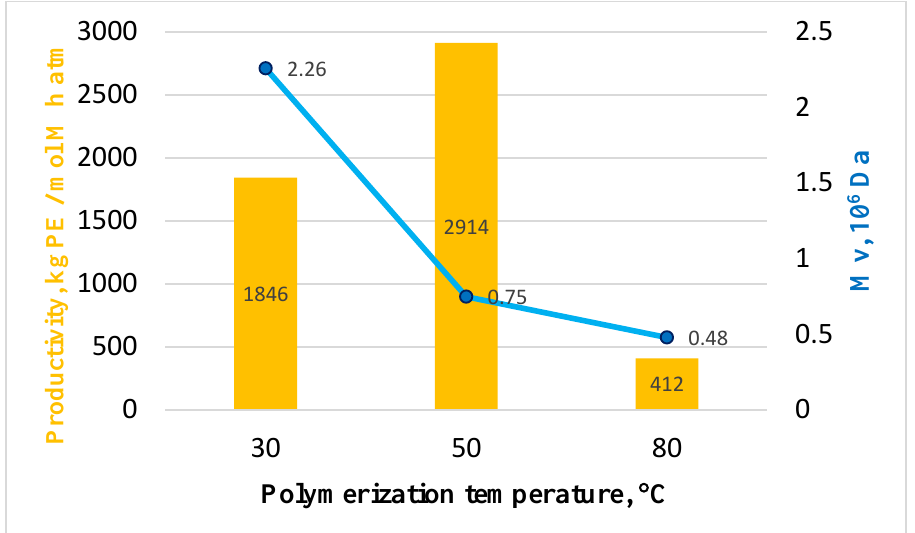
Figure 4. Dependence of the activity of the catalyst systems and molecular weight of PE on the polymerization temperature.